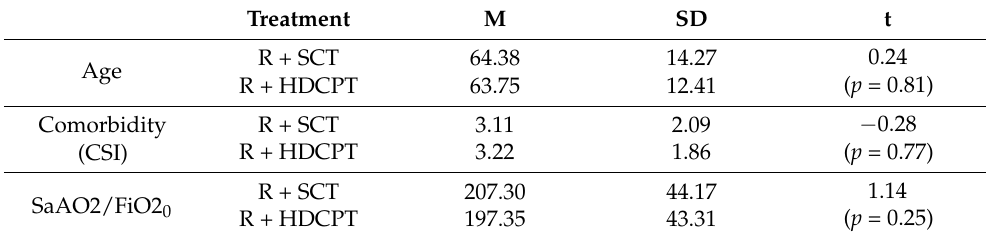
Table 1. Baseline demographics and clinical characteristics of study patients.